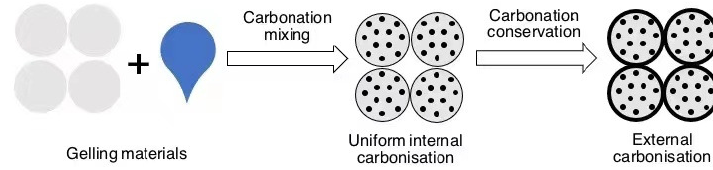
Figure 10. Stirred carbonation